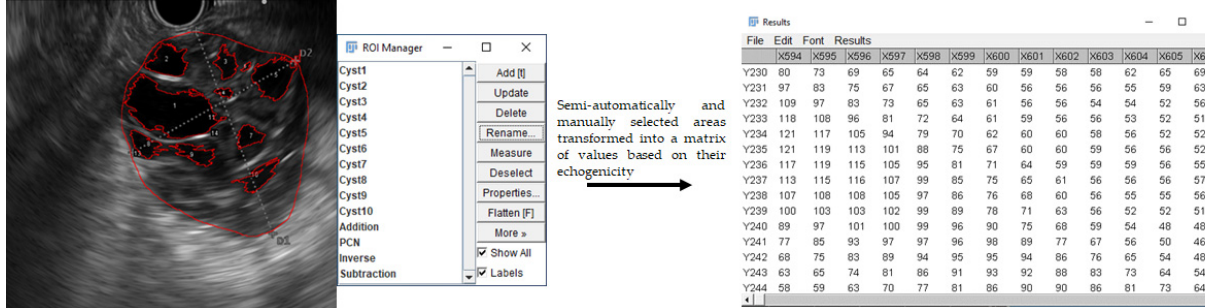
Figure 1. Image analysis method.